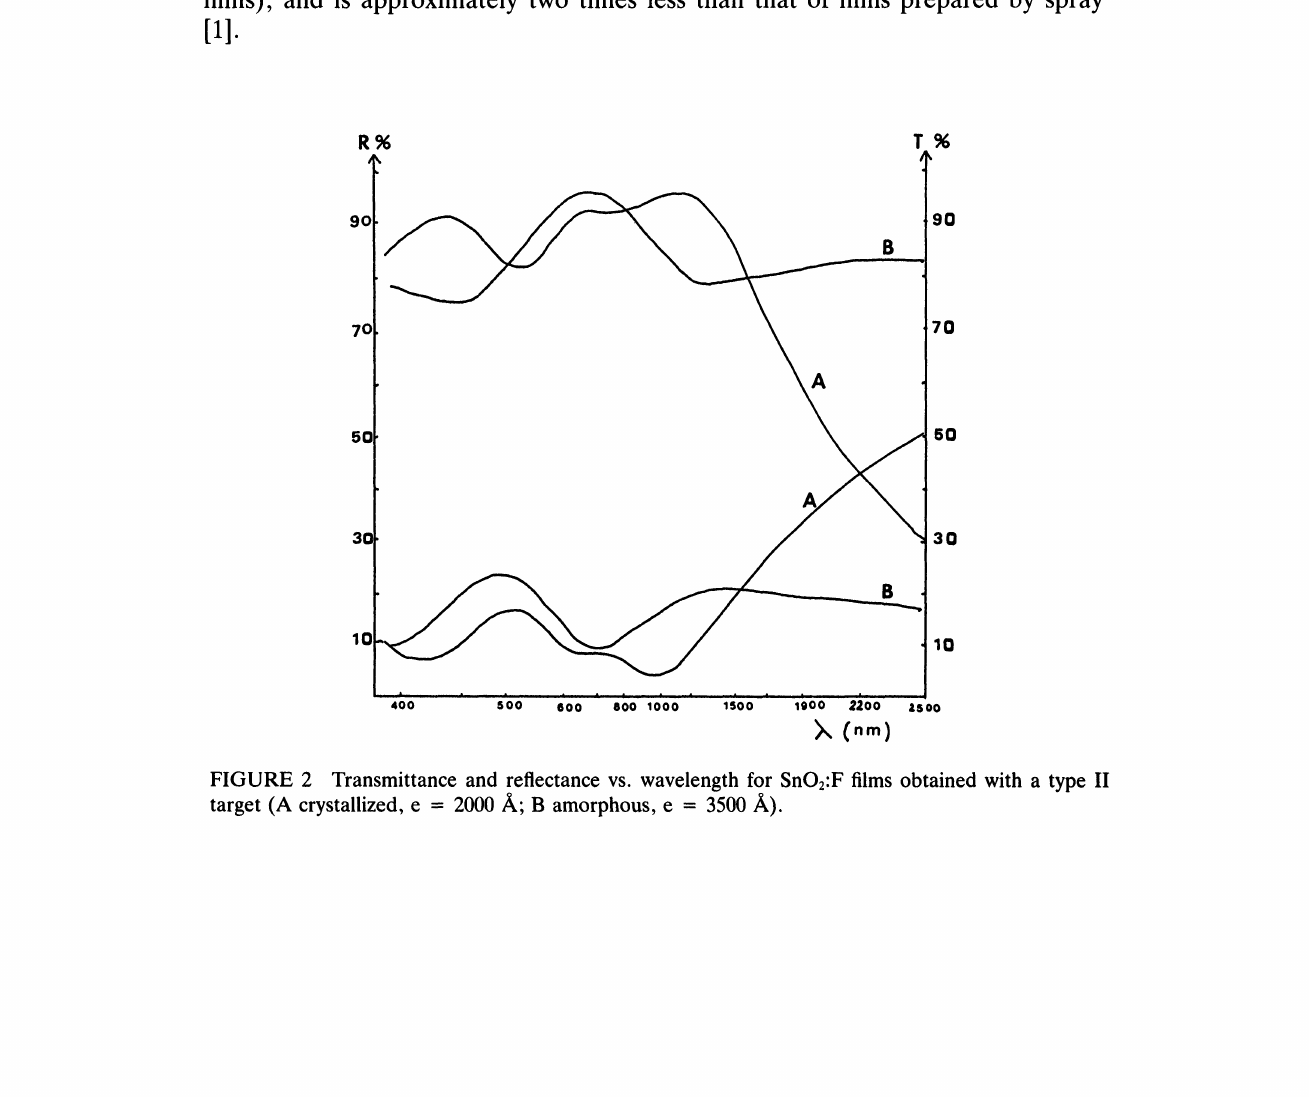
FIGURE 2 Transmittance and reflectance vs. wavelength for SnOz:F films obtained with a type II ; B amorphous, e target (A crystallized, e 2000